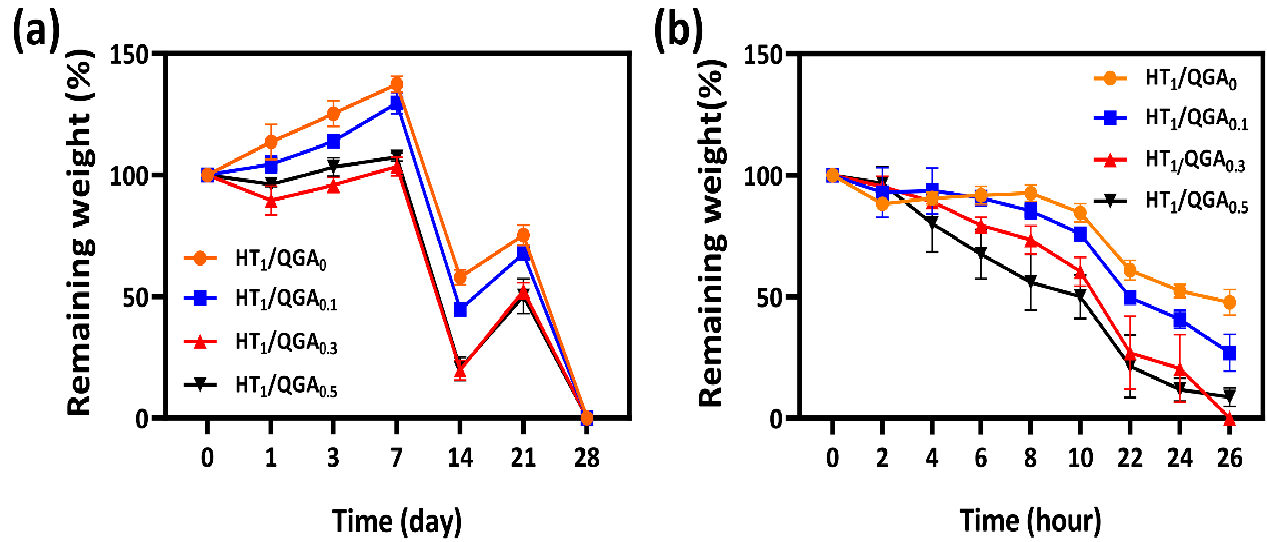
Figure 4. ( a ) In vitro stability and ( b ) biodegradability of HT/QGA hydrogels. Mean ± SD, n = 3.